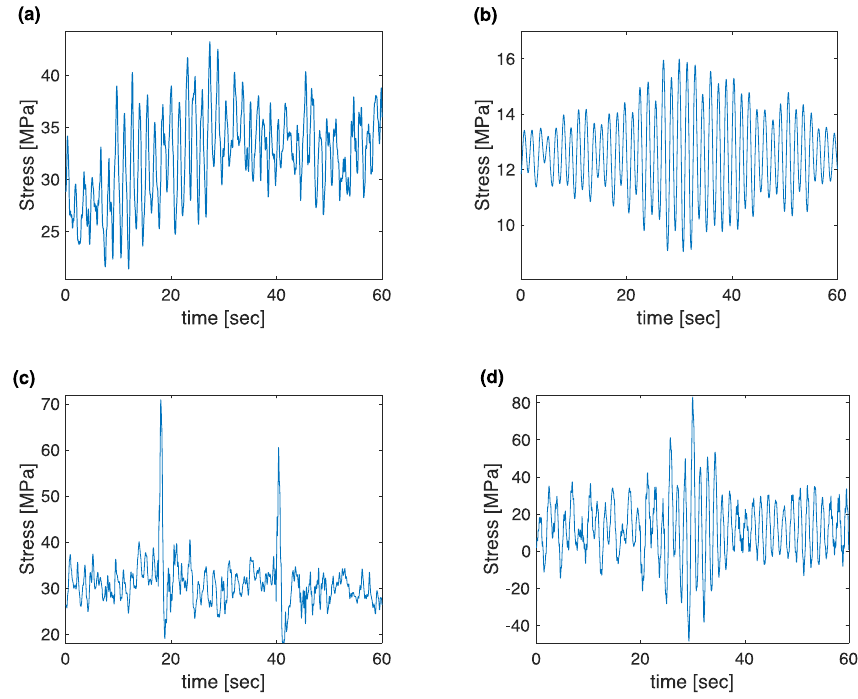
Figure 2. Example of a 60 s stress-time series of structural response obtained from the BHawC numerical model for cases with the highest occurrence probability of DLC12 ( a ) and DLC64 ( b ), and two exemplary series for DLCD4 ( c ) and DLCD7 ( d ) with different structure-ice interaction processes.